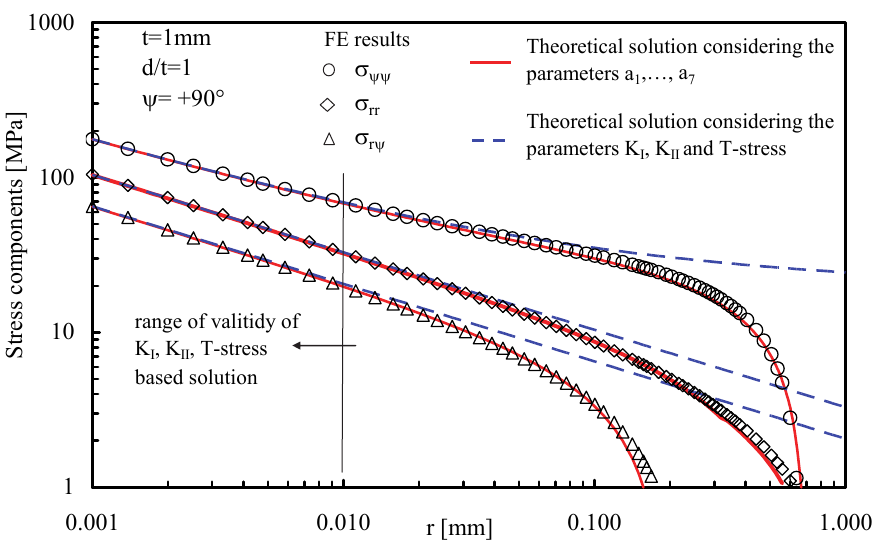
Figure 3: Stress field along the direction  =90° for the case